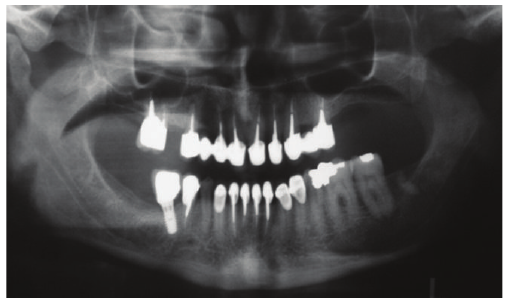
Figure 7: Panoramic view of